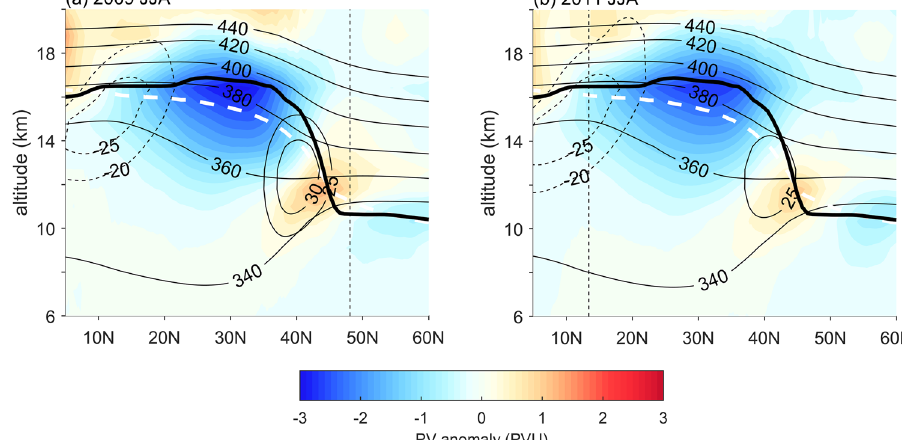
Fig. 2 Meteorological conditions in the ASMA (based on the ERA5 reanalyzes). Potential vorticity (PV) anomaly (shaded, unit: PVU) in the approximate longitude range of the ASMA (40 – 120°E) for a 2009 (June-July-August) and b 2011 (June-July-August). The zonal wind is averaged between 40 – 120°E with solid black contours indicating the westerlies and dashed black contours indicating the easterlies. The dashed white line indicates the mean tropopause over 0 – 360°E, and the thick black line indicates the mean tropopause between 40 – 120°E. The thin black lines indicate the potential temperature. Vertical dashed lines mark the latitudes of the